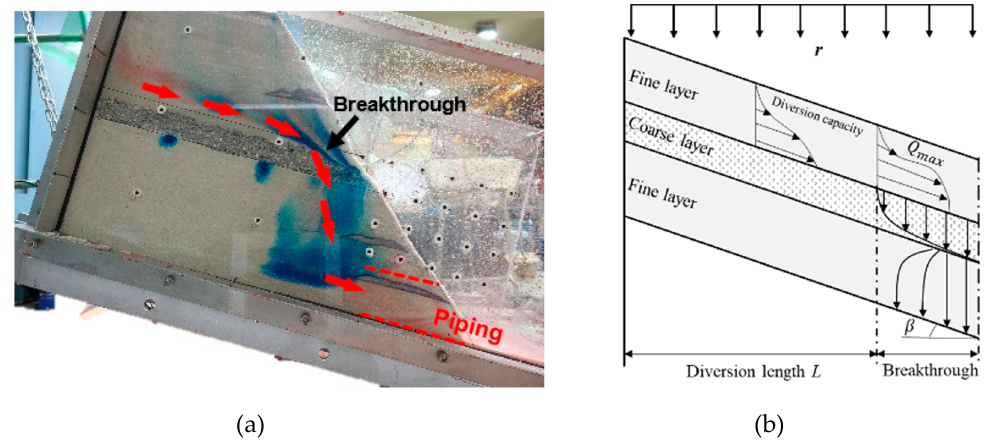
Figure 17. ( a ) Side view of the diversion length and breakthrough area of the capillary barrier (the movement and the breakthrough zone are shown by the blue dye traces); ( b ) calculation of the capillary diversion length L.